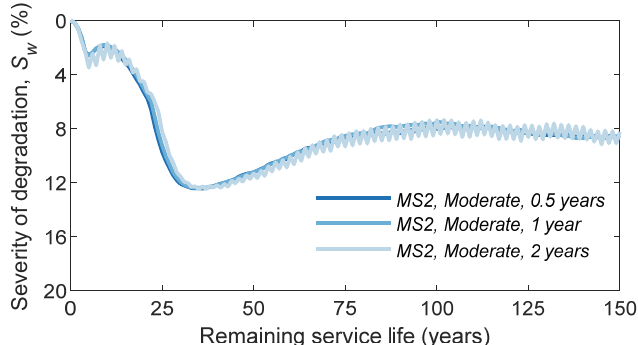
Figure 7. Degradation profiles of the three inspection frequencies.